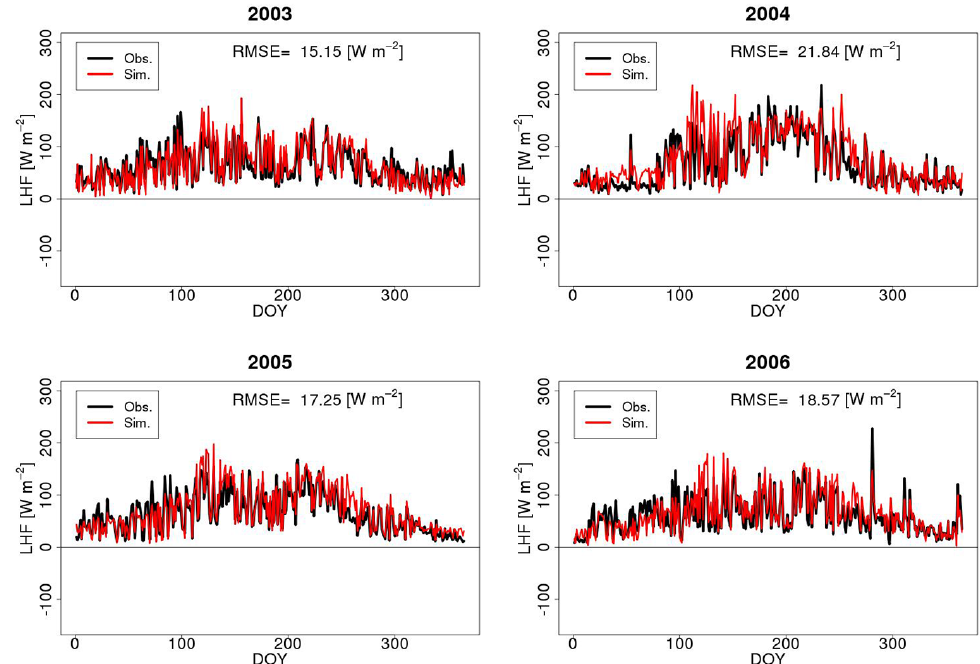
Figure 7. Comparison of daily LHF between simulations and observations. DOY indicates the number of days from 1 January.